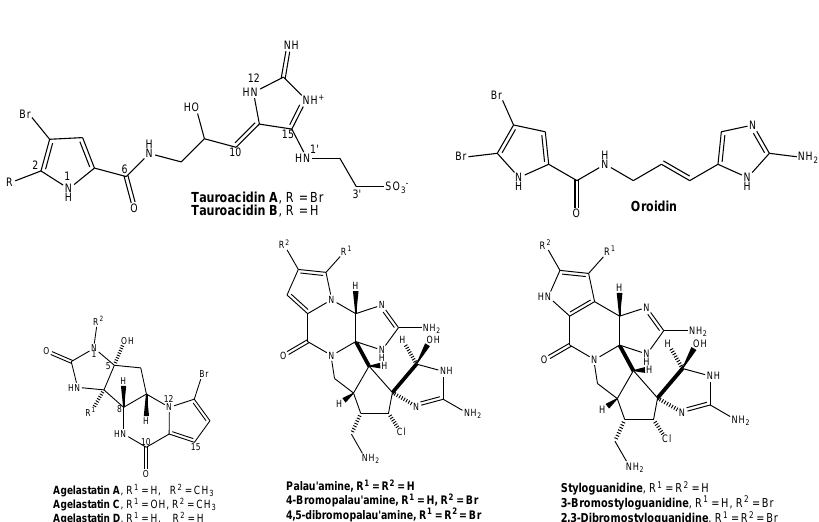
Figure 10. Some bioactive halogenated-pyrrole derivatives from